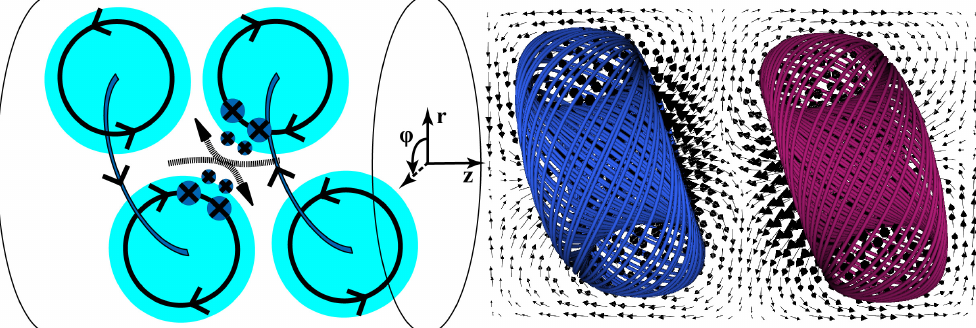
Fig. 1. A cartoon (left panel) and HiFi simulation (right panel) of two tilting spheromaks undergoing magnetic reconnection at the central magnetic null. The cartoon indicates the reconnecting in-plane B -field components and the co-directed out-of-plane B -field being convected into the RR. The simulation panel shows streamlines of two separate magnetic field-lines, and arrows show the magnetic field direction and strength at the mid-plane. Note that the two spheromaks have oppositely directed toroidal magnetic fields.